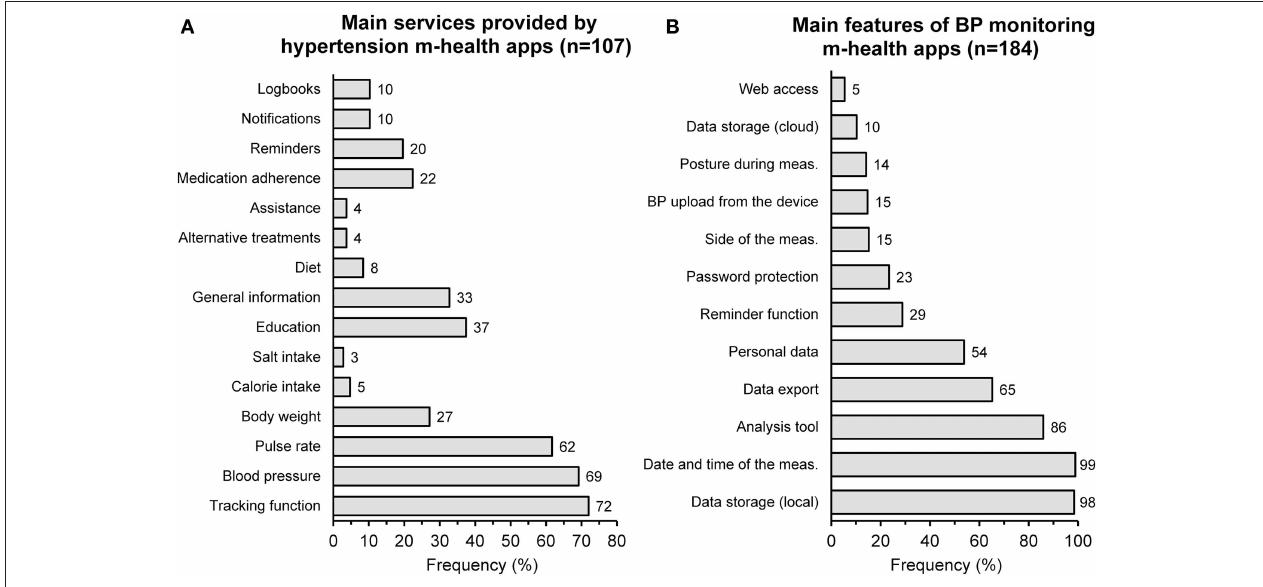
FIGURE 4 | Main services provided by hypertension m-health apps according to a survey of 107 different products (A) and main characteristics of m-health apps used for blood pressure (BP) monitoring according to another survey of 184 applications (B) [redrawn from (52) and (53) by